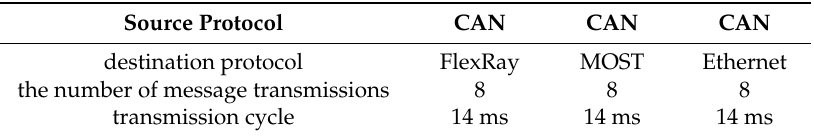
Table 2. The Simulation Environment.